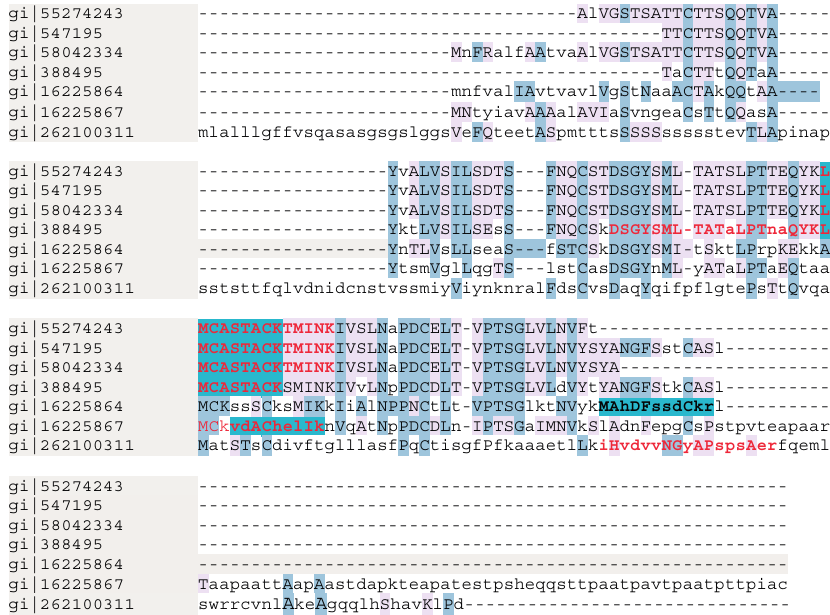
Figure 6. Alignment of peptides sequences obtained from MS/MS analysis (in bold) of F1b CCF active fraction (highlighted in blue) and crude CCF (in red) with elicitin peptide sequences in the NCBI